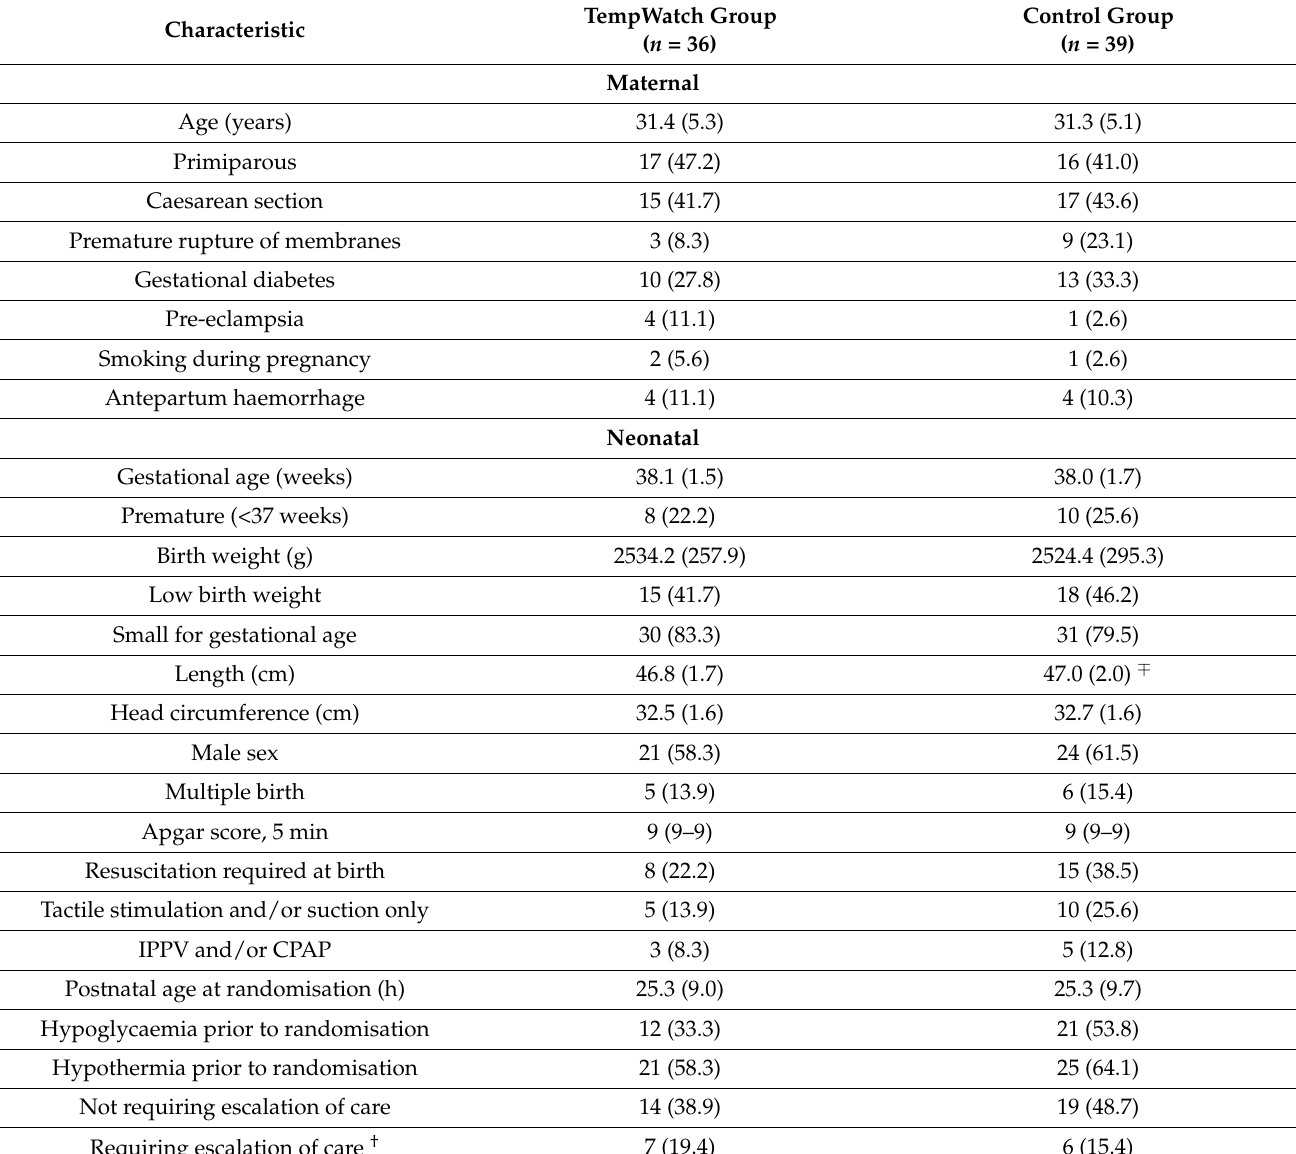
Table 1. Demographic characteristics of mothers and